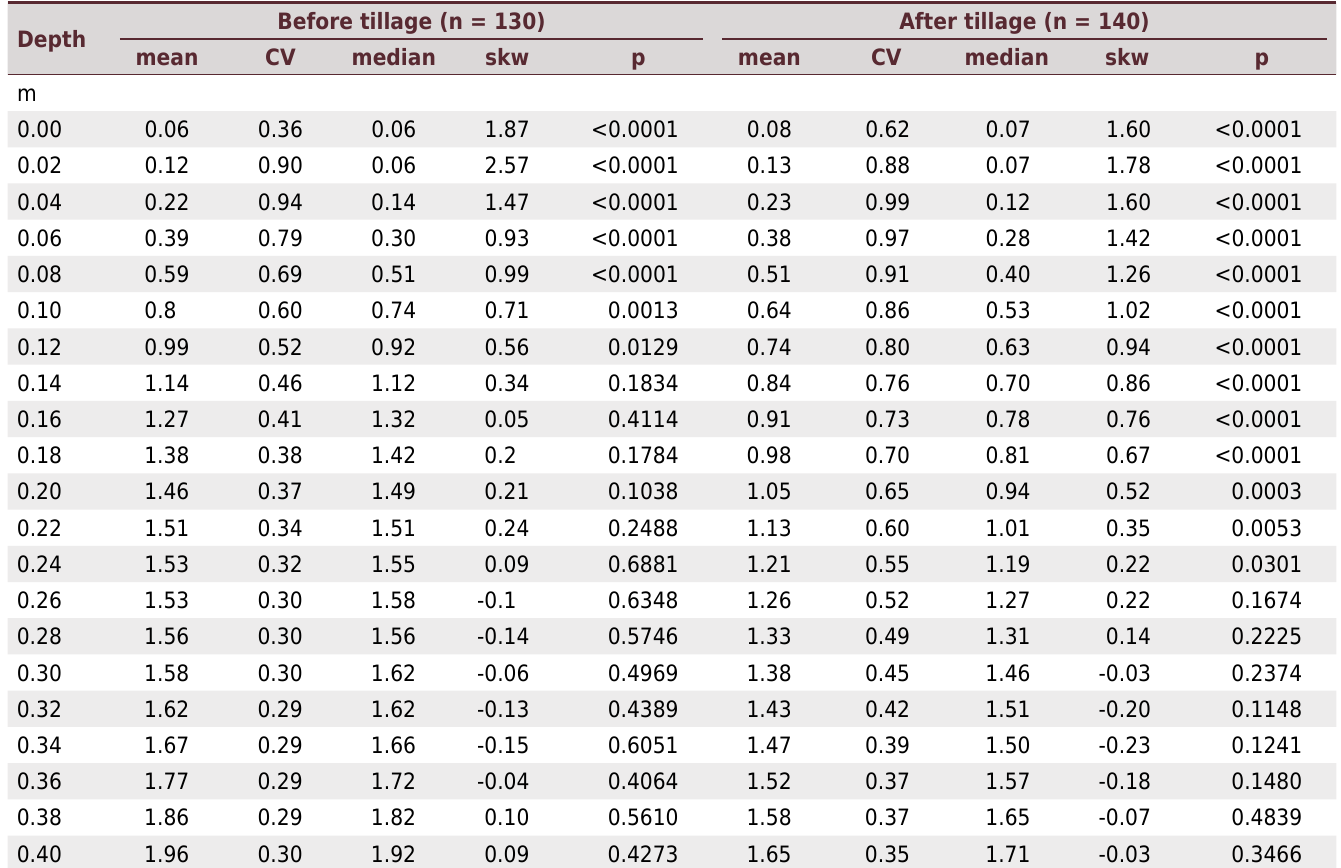
Table 2. Summary statistics of cone index (CI, MPa) recorded before and after tillage in 0.02-m intervals from the soil surface to the maximum measured depth (0.40 m) Before tillage (n = 130) Depth